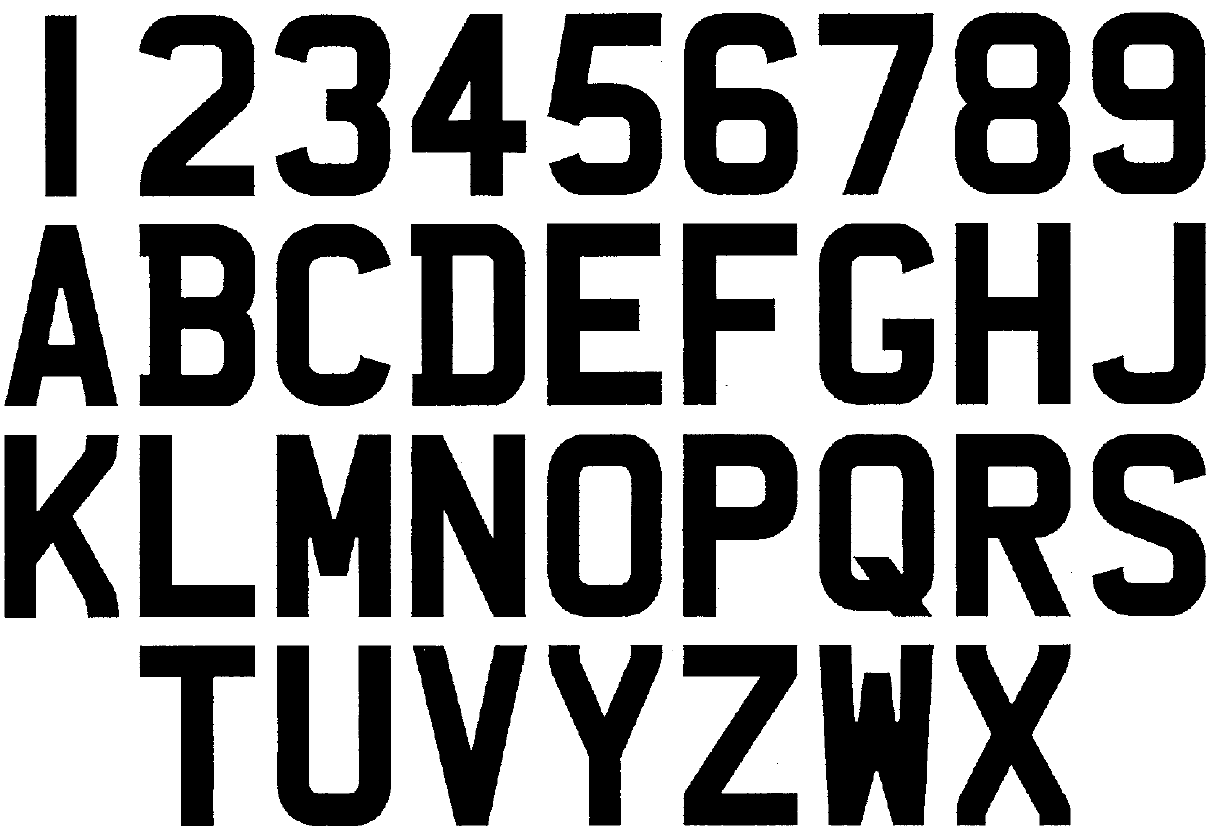
Figure 1 . ‘Font Described for Characters 79 Milimetres in Height [sic]’ from 2001 Regulations, sch 4 pt 1 Originally designed in London in 1935 by the sheet metal pressing company Charles Wright and Son, 16 this prescribed font represents a font of specifically English origin that is imposed on vehicles across the UK. It was updated in 2001 to allow for changes in European regulation (the inclusion of the EU country identifier) and technology (digitally printed acrylic now enables more precise characters and thus optimisation for optical character recognition). 17 These basic reforms already indicate some concern with the appearance of these marks, but the full regulations go beyond simply prescribing a font. The 2001 Regulations’ detailed intervention in how registration marks should be displayed suggests that the manner of their presentation is important: it is not simply that they must be legible, but that a specific size, style and arrangement of the marks on registration plates must be adhered to. Thus, the 2001 Regulations indicate that the point of mediation between a vehicle and the UK state should take a particular form and format—that the visual appearance of these regulatory tools matters. The obvious presumption is that this appearance matters simply for their practical functioning, but the detail and extent of the visual control exerted by the 2001 Regulations indicates that they are of wider significance, as will be explored in the second half of the paper. There is some limited jurisprudence on the UK regime surrounding registration marks, but none of it directly discusses the visual appearance of marks or the content of the 2001 Regulations. For instance, while Value Added Tax is payable on the sale of personalised registration marks by the UK’s Driver and Vehicle Licensing Agency (‘DVLA’), 18 there is no property in registration marks themselves, 19 with such purchases being contracts for the transfer of a registration number to the buyer’s vehicle via prescribed statutory mechanisms, rather than for the purchase of the mark as an object or a thing in action. 20 Accordingly, it is the statutory regime itself that will be the focus of the following